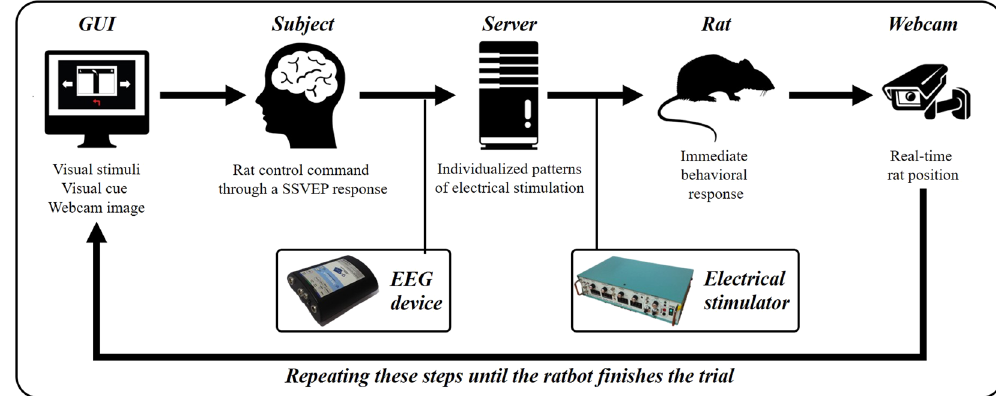
Figure 5. Schematic overview of the proposed rat-navigation system. This overview explains how information flowed between the human participant and the ratbot during an experimental trial. Two directional arrows on the GUI flickered at different frequencies to induce the SSVEP response from the participant. At the same time, the visual cue on the GUI indicated the goal for the current trial. To make the ratbot move in the intended direction, the participant selectively generated the SSVEP response by concentrating on one of the flickering arrows or ignoring both. If three sequential SSVEP responses corresponded to the left or right flickering arrow, they were considered to be a command to turn left or right, respectively. If not, they were considered to be a command to move forward. The server recognized the command by analysing the EEG signals, and then delivered the appropriate customized stimulation pattern through the neural stimulator to the electrodes implanted in the rat’s NS pathways. Because the maze was displayed in real-time on the computer monitor, the participant could recognize when and how the patterned stimulation induced the behavioural response from the rat. These steps were repeated until the experimental trial has been completed.